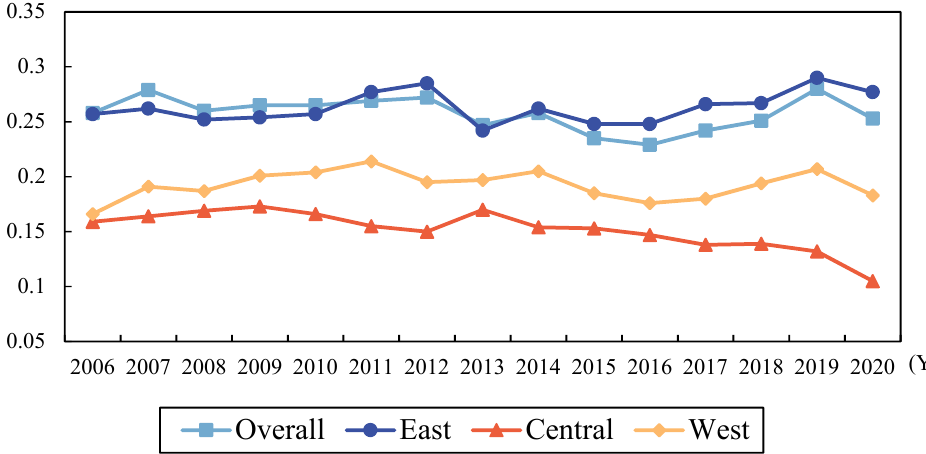
Figure 3. Variation of the overall and intra-regional differences of the livelihood resilience of rural residents in China. Source: the authors’ own work.